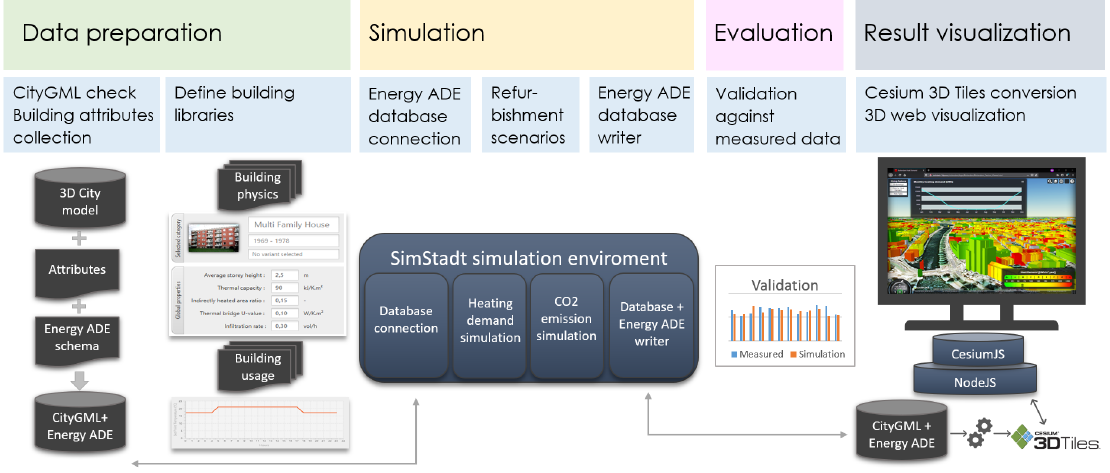
Figure 2. Overview of the proposed